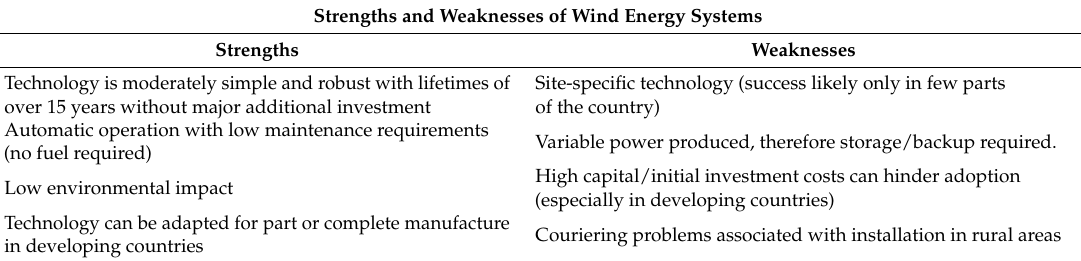
Table 3. Information adapted from a RET module [42] available